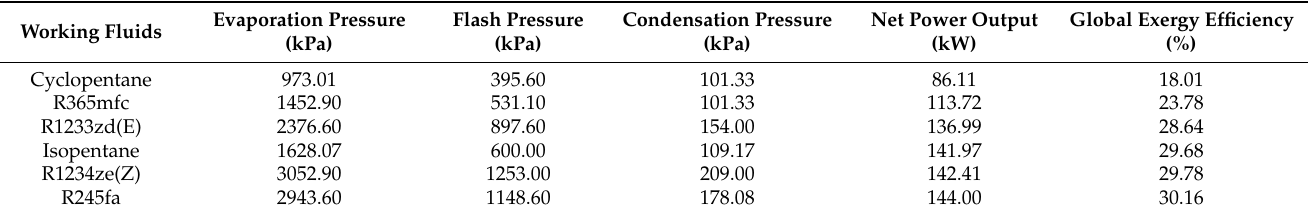
Table 5. Optimized global exergy efficiency and corresponding parameters for an ROFC with a heat source of 150 ◦ C, and a cooling water temperature of 20 ◦ C.